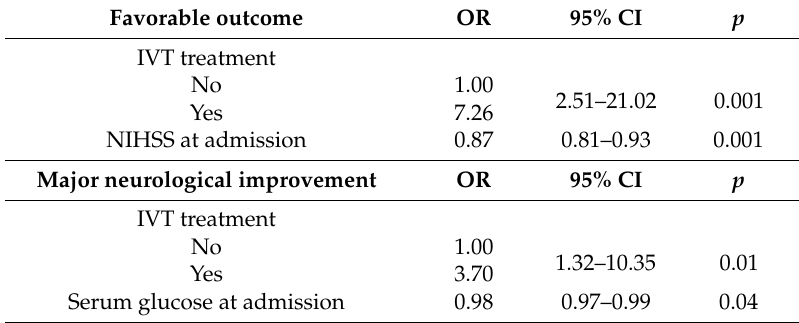
Table 4. Multivariable analyses showing the independent predictors of favorable outcome and major neurological